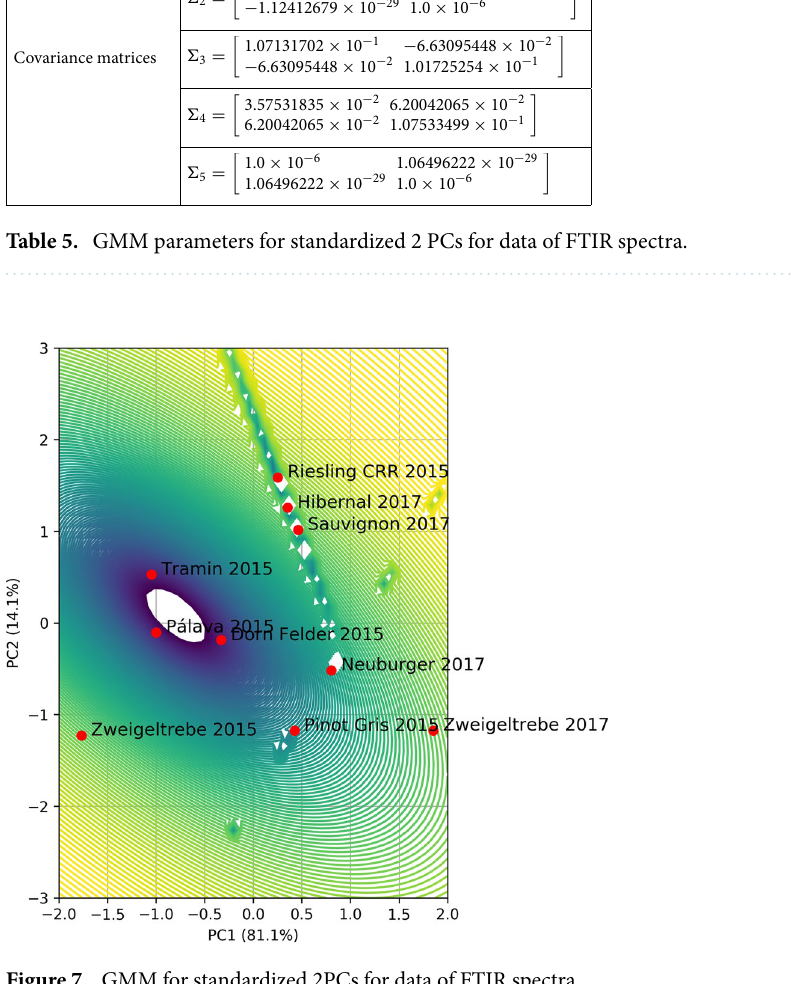
Figure 7. GMM for standardized 2PCs for data of FTIR